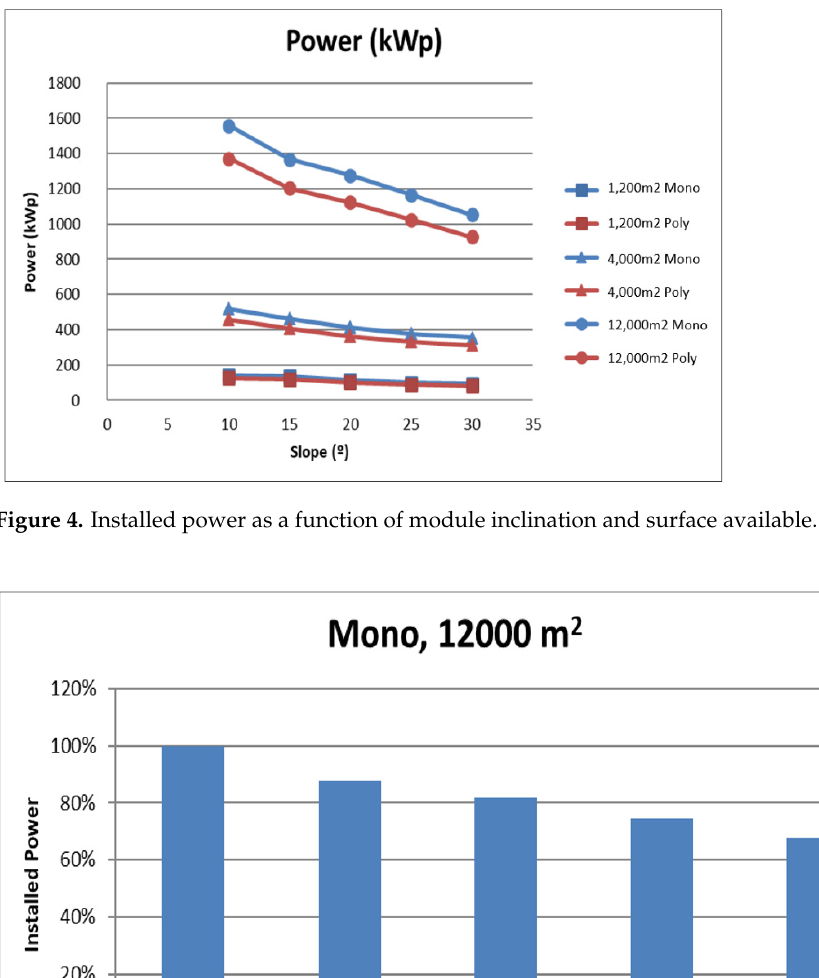
Figure 5. Installed capacity as a function of module inclination.